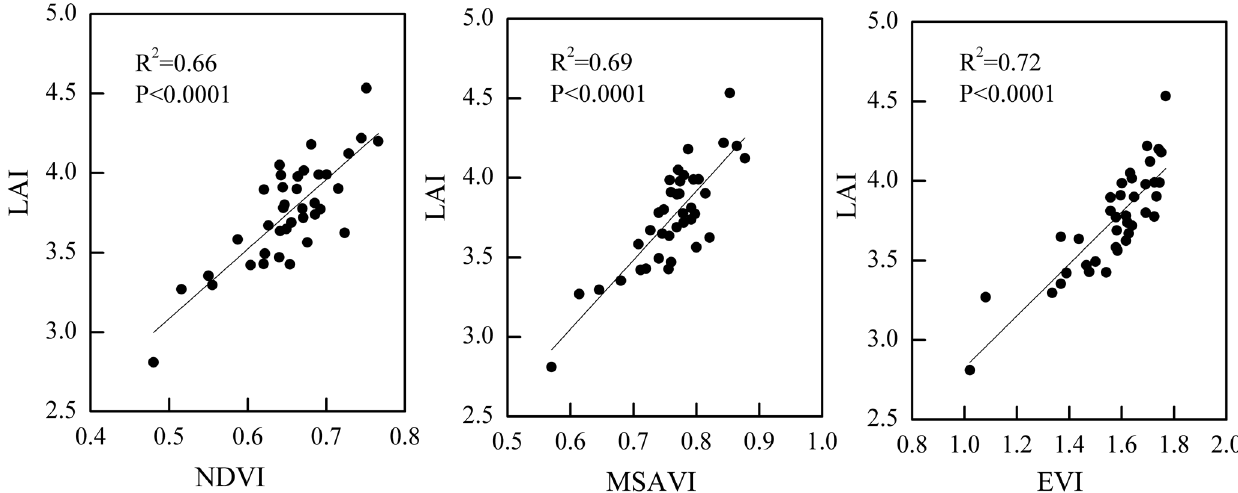
Figure 4. Linear relationships between three vegetation indices (VIs) and leaf area index (LAI) during the peak growing season of maize in three counties in North China (n=38). The VIs are: normalized difference vegetation index (NDVI), enhanced vegetation index (EVI), and modified soil adjusted vegetation index (MSAVI).